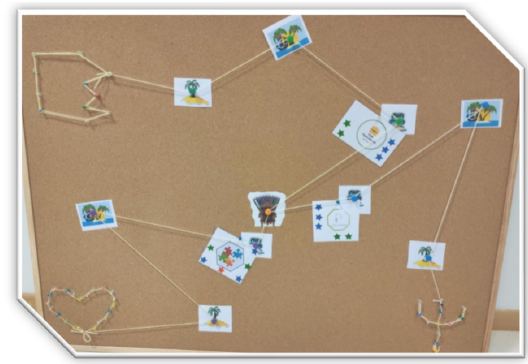
Figure 1. A simplified gamified process map.